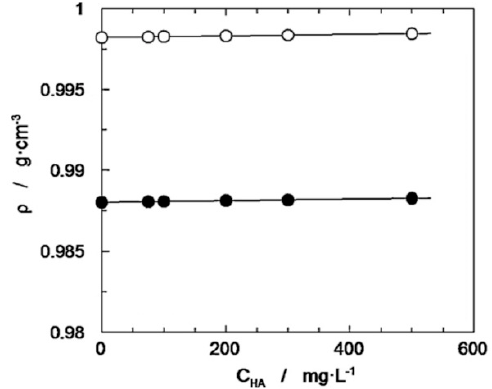
Figure 13. Dependence of the density on hyaluronic acid concentration and temperature: ( ○ ) T = 20 °C, ( ● ) T = 50 °C. Adapted from [76], with permission from Elsevier, 2020.